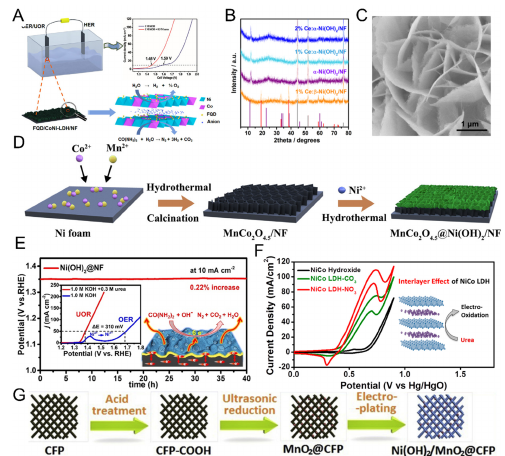
Figure 2. ( A ) FQD/CoNi–LDH/NF catalysts for efficient water and urea splitting [49]. Reproduced with permission [49]. Copyright 2020, Elsevier B.V. ( B , C ) XRD patterns and SEM images of the sam- ple [50]. Reproduced with permission [50]. Copyright 2019, American Chemical Society. ( D ) Illus- tration of triple-layered MnCo 2 O 4.5 @Ni(OH) 2 /NF nanosheet arrays [52]. Reproduced with